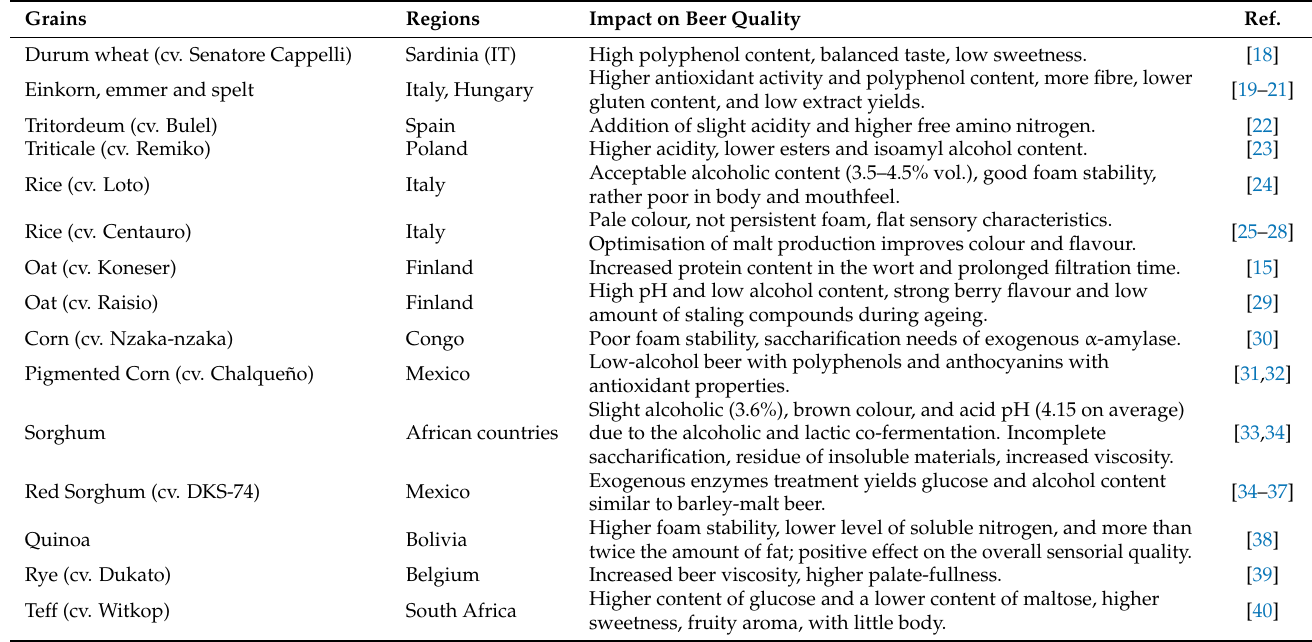
Table 1. Cultivars, origins, and impact of grains that were recently investigated for their brewing potential. Grains Regions Impact on Beer Quality Ref. Durum wheat (cv. Senatore Cappelli) Sardinia (IT) High polyphenol content, balanced taste, low sweetness. Einkorn, emmer and